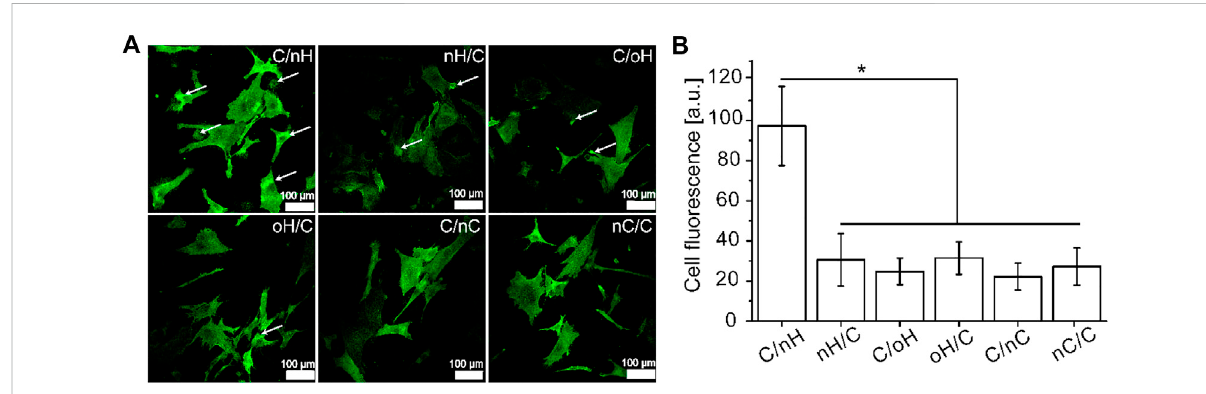
FIGURE 3 The adhesion of hUC-MSCs grown on different PEM (A) CLSM with staining of CD44 (green) of hUC-MSCs after 4 h incubation on thedifferent PEM,and the fl uorescence signalsofCD44 (B) wasquanti fi edbyImageJandcorrected totalcell fl uorescencewascalculatedby fl uorescencesignal with elimination of background signal [PEM were prepared with terminal layer of nHA, oHA and nCS (C/nH, C/oH, C/nC) or outermost layer of Col I (nH/C, oH/C, nC/C). Cells were seeded in serum free medium for 4